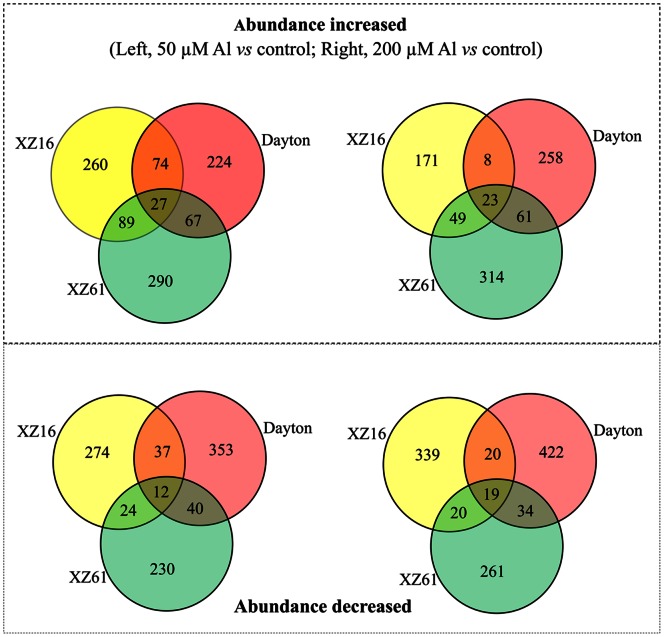
Venn diagram illustrating the expression patterns of Al stress-responsive proteins in roots of XZ16, XZ61 and Dayton.The numbers of differentially expressed spots up- or down-regulated are shown in the different segments. As to protein spots altered by 50 and 200 µM Al stress, 450, 473, 392 spots (50 µM Al vs control) and 251, 447, 350 spots (200 µM Al vs control) were up-regulated in XZ16, XZ61, Dayton, respectively; while 347, 306, 442, and 398, 334, 495 spots down-regulated. The abundance of 101, 31 spots increased in both of XZ16 and Dayton under 50, 200 µM Al stress, respectively, and that of 49, 39 decreased.